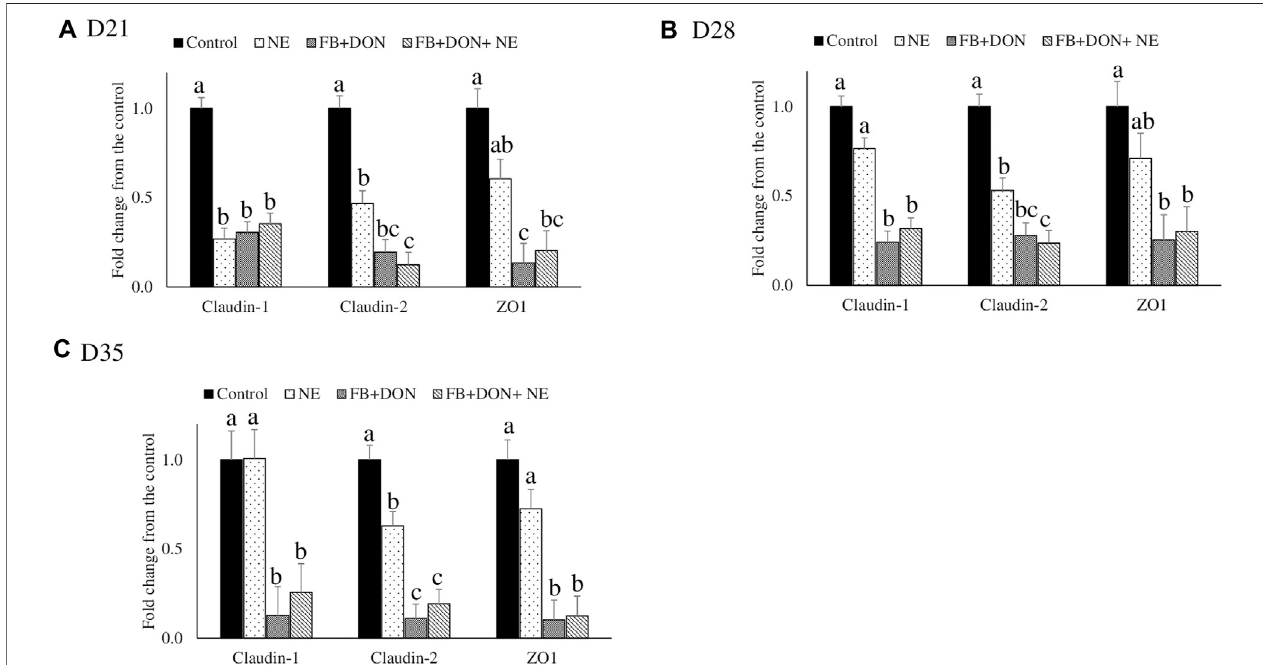
FIGURE3| EffectofsubclinicaldoseofFB+DONand E.maxima/C.perfringens challengeonjejunaltightjunctionproteinmRNAexpression.Day-oldchickswere distributedintofourtreatmentgroups:control,necroticenteritis(NE),fumonisin+deoxynivalenol(FB+DON),andFB+DON+NEgroups.BirdsintheNEandFB+DON + NE groups received 2.5 × 10 3 Eimeria maxima oocyst per bird on day 14. All birds received 1 × 10 8 CFU/bird of Clostridium perfringens on days 19, 20, and 21. Tight junctionproteinmRNAcontentwasanalyzedaftercorrectingforthehousekeepinggeneRPS13mRNAcontentandnormalizingtothemRNAcontentofthecontrol group at D21 (A) , D28 (B) and D35 (C) , so all bars represent fold change compared to the control group. Bars (+SEM) without a common superscript differ signi fi cantly ( p < 0.05). n = 8 (8 pens of 15